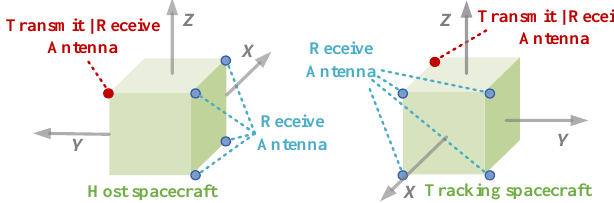
Figure 21. Principles diagram of radio state measurement.